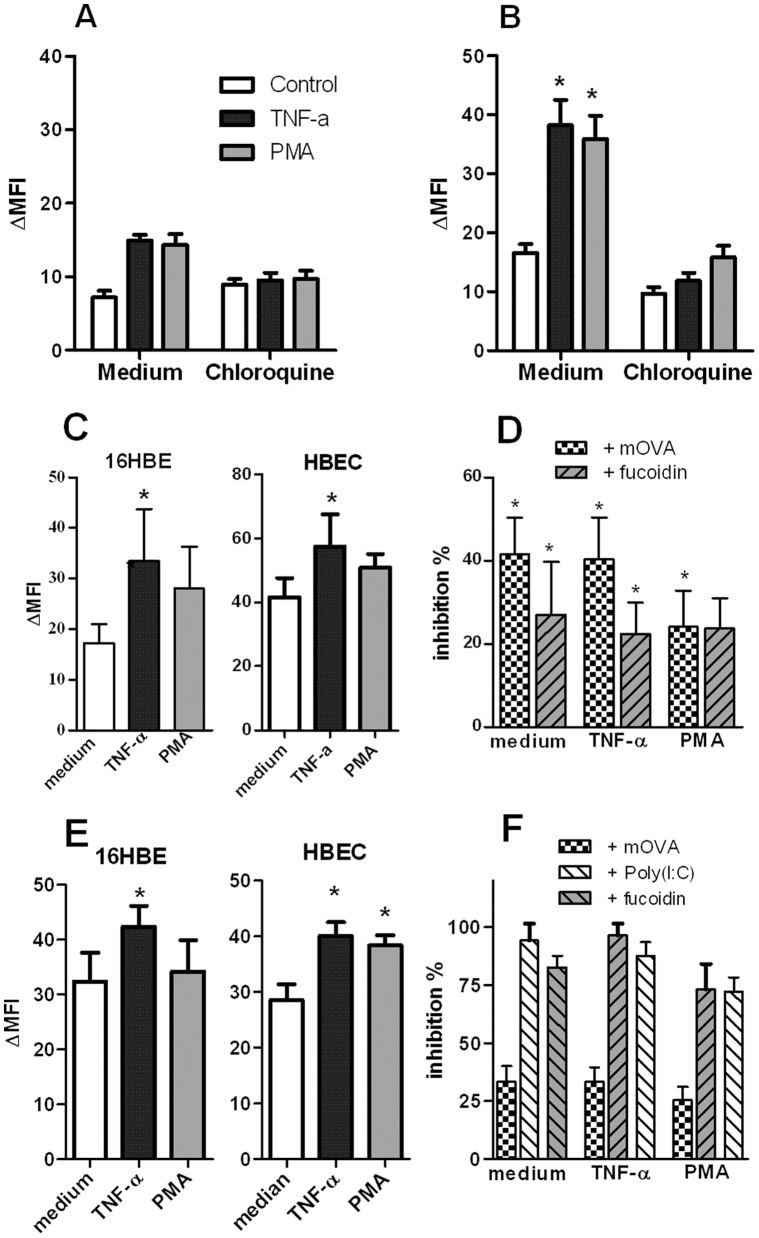
Endocytosis of SR ligands and dsRNA by BEC.(A–B) Uptake of AlexaFluor®488-labelled Ac-LDL by 16 HBE cells. 16 HBE cells were stimulated with TNF-α (20 ng/mL) or PMA (10 ng/mL), in the absence or presence of chloroquine (100 µM), and then, were exposed for 30 minutes (A) or 1 hour (B) with labelled-Ac-LDL (10 µg/mL). The binding of the ligand was assessed by flow cytometry (n = 3). (C) mOVA binding is measured in 16 HBE cells and HBEC activated for 24 h with TNF-α and PMA. Cells were incubated for 1 h with FITC-conjugated mOVA. MFI was determined by flow cytometry. (D) Inhibition of mOVA uptake by unlabelled SR ligands. An excess of unlabelled mOVA and fucoidin was added 10 min before addition of FITC-labelled-mOVA. Data were expressed as the mean ± SEM from 5 to 13 independent experiments. (E) Modulation by TNF-α and PMA of the biotinylated poly(I:C) endocytosis in 16 HBE cells (left panel) and HBEC (right panel). Data are expressed as the mean ± SEM of ΔMFI (n = 4 to 5 experiments). (F) Inhibition of poly(I:C) binding by mOVA, fucoidin and unlabelled poly(I:C) on 16 HBE cells activated or not with TNF-α and PMA. Mean ± SEM of the percentages of inhibition were reported (n = 3). *: p<0.05, **: p<0.01 versus control cells.